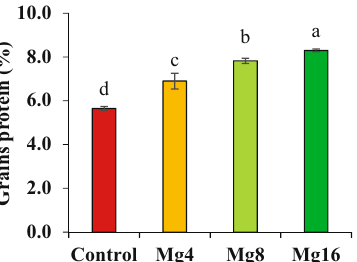
Figure 3: Maize grains protein content cultivated under various levels of Mg in calcareous soils. Red bar indicates minimum, orange bar indicates low, light green bar medium and green bar indicate maximum green